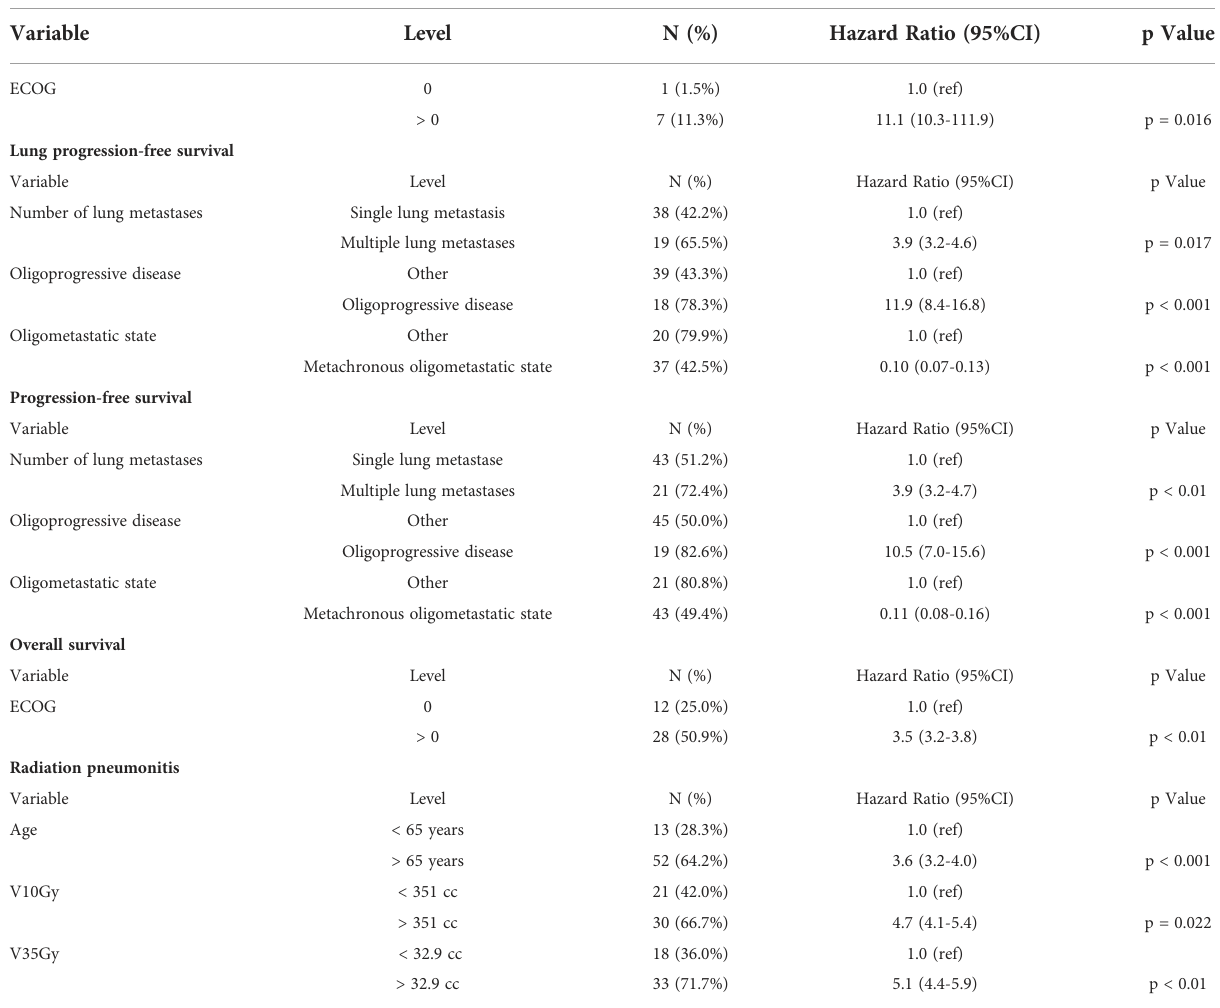
TABLE 2 Univariable analysis of prognostic